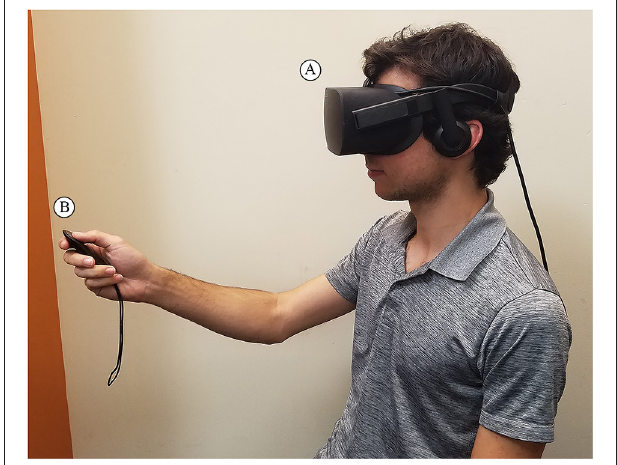
FIGURE 1 | The experimental setup depicting a participant (A) wearing an Oculus Rift HMD to view the immersive VR clips, and (B) holding an Oculus. Rift remote to select his affective responses to his viewing